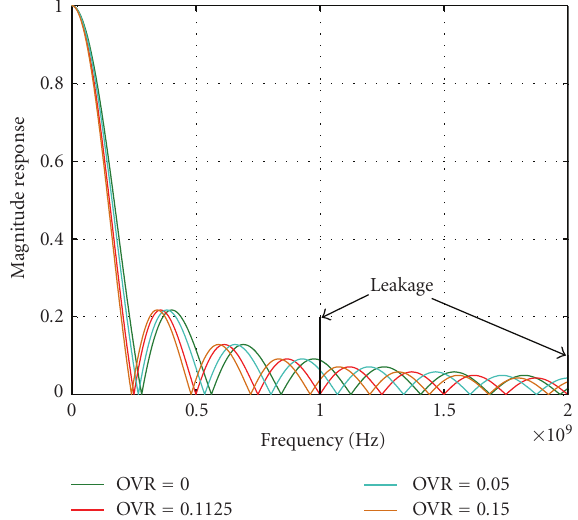
Figure 7: The location of the spurious leakage frequency relative to the filter nulls with di ff erent overlapping ratio. With OVR = 0, the strongest clock leakage is close to the peak of the filter’s 3rd sidelobe; with OVR = 0 . 1125, the strongest clock leakage is on the 4th null of the